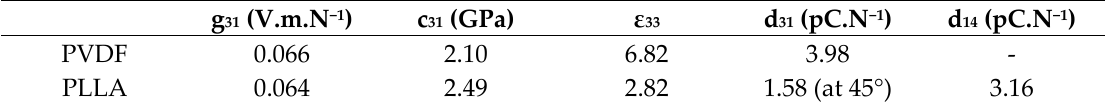
Table 1. Obtained coefficient of PVDF and